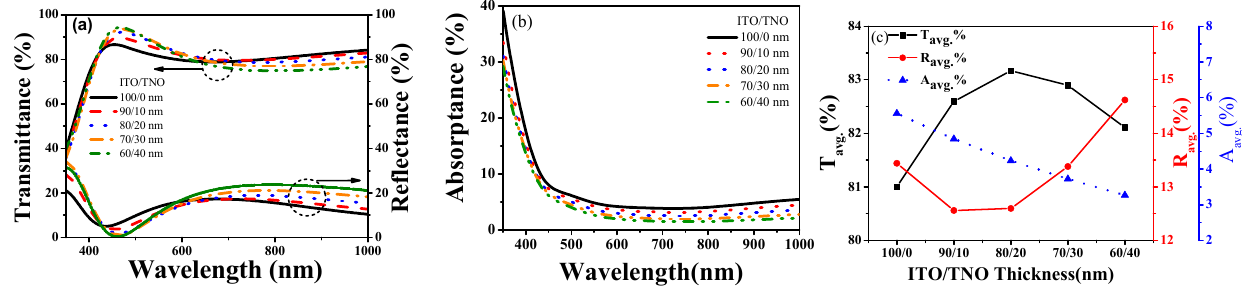
Figure 5. ( a ) Macleod simulated transmittance and reflectance spectra of double-layer ITO/TNO with different thickness combinations on the glass substrates as a function of wavelength, ( b ) corresponding absorptance spectra, and ( c ) corresponding simulated average transmittance, reflectance, and absorptance in the wavelength range of 400–800 nm .